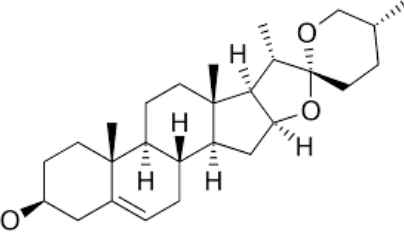
Figure 1. Chemical structure of diosgenin.